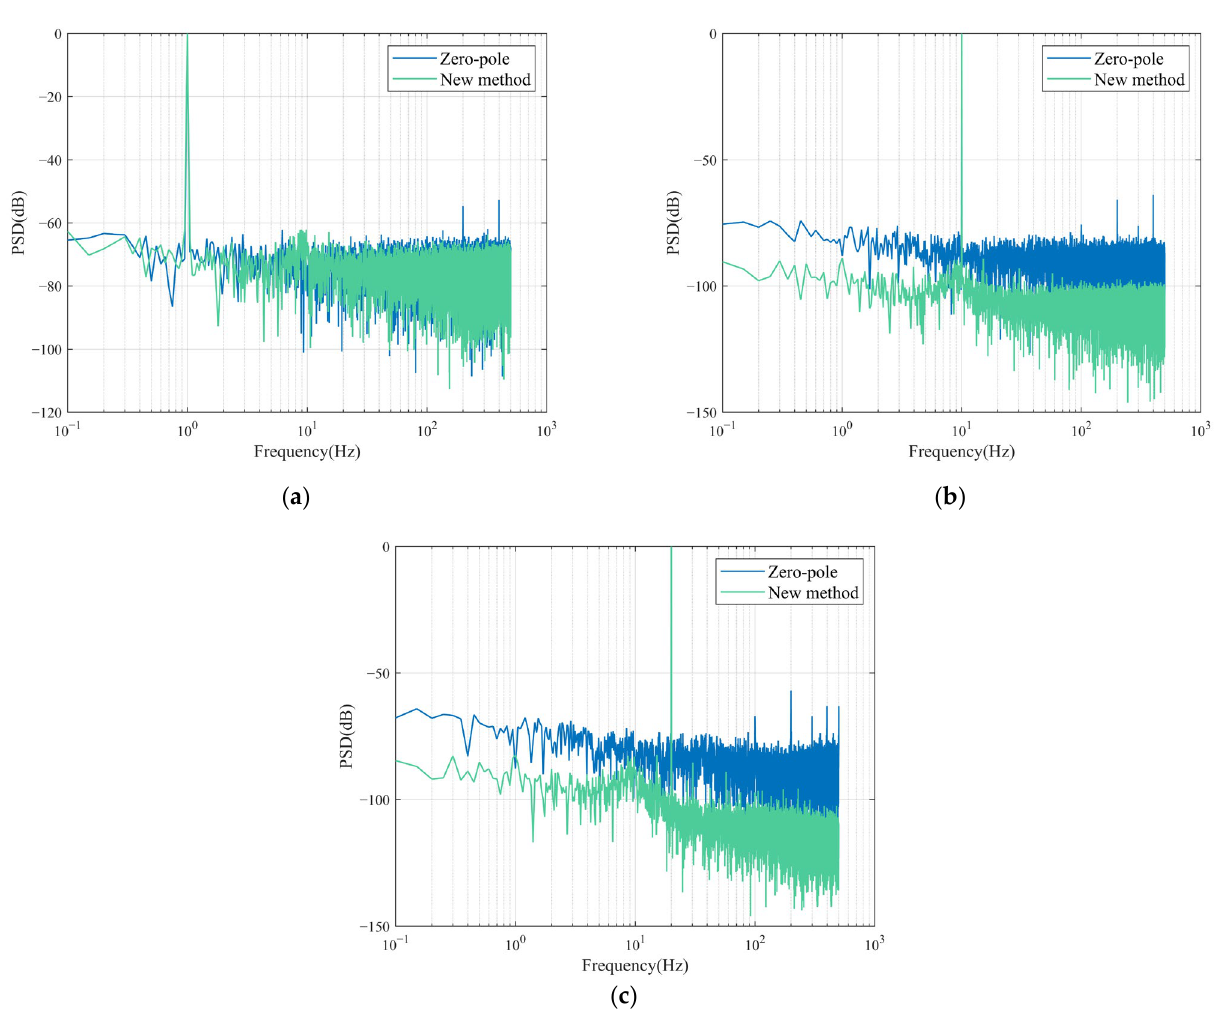
Figure 13. ( a ) PSD of two improvement methods for 1 Hz vibration signal; ( b ) PSD of two improvement methods for 10 Hz vibration signal; ( c ) PSD of two improvement methods for 20 Hz vibration signal.